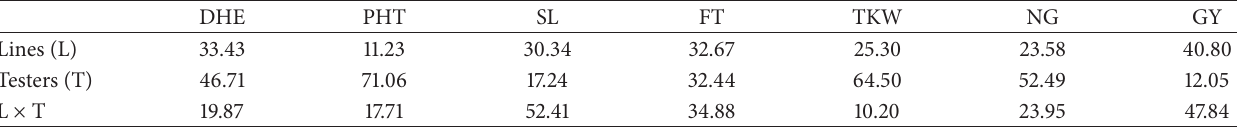
Table 8: Proportional (%) contribution of lines, testers, and lines × testers to total hybrids variation in bread wheat. DHE PHT SL FT TKW NG